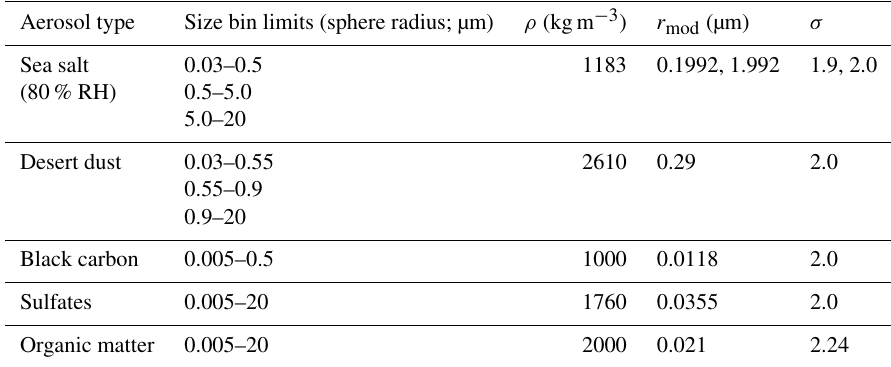
Table 2. Aerosol species and parameters of the size distribution associated with each aerosol type in OpenIFS/AC ( r mod is mode radius, ρ is particle density, and σ is geometric standard deviation). Values are for the dry aerosol, apart from sea salt, which is given at 80% relative humidity (RH).